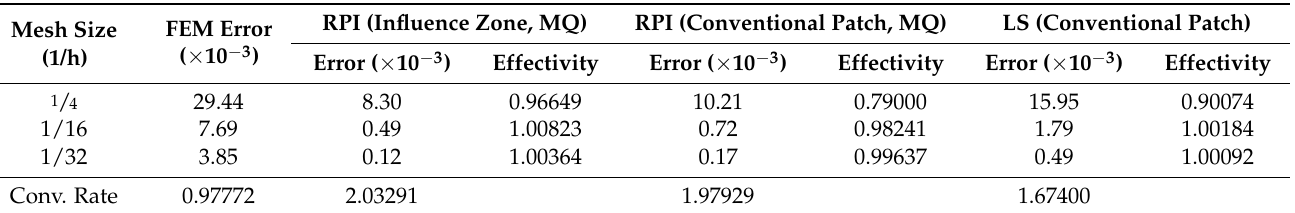
Table 2. Error properties results for LS- and RPI (MQ)-based recovery approach in incompressible- elastic plate analysis considering influence zones and conventional patches (nine-node quadrilateral regular mesh).